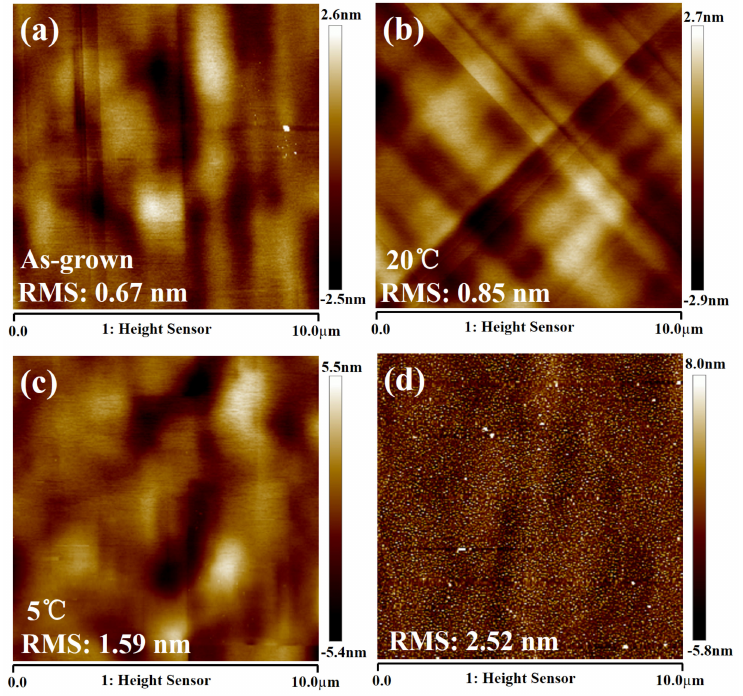
Figure 10. Typical AFM images (10 × 10 µ m 2 ) of flat (100) Ge surfaces before and after the etching process: ( a ) as–grown; ( b ) ALE with 20 cycles (temperature of HNO 3 = 20 ◦ C); ( c ) ALE with 20 cycles (temperature of HNO 3 = 5 ◦ C); ( d ) HF:HNO 3 :CH 3 COOH